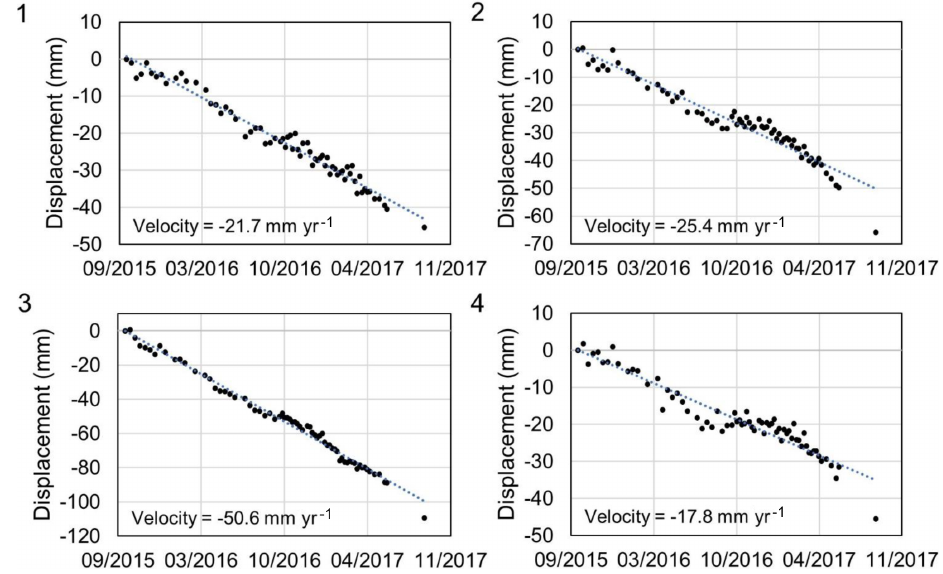
Figure 5. Displacement time series of four points selected in the hotels’ cadastral parcels.